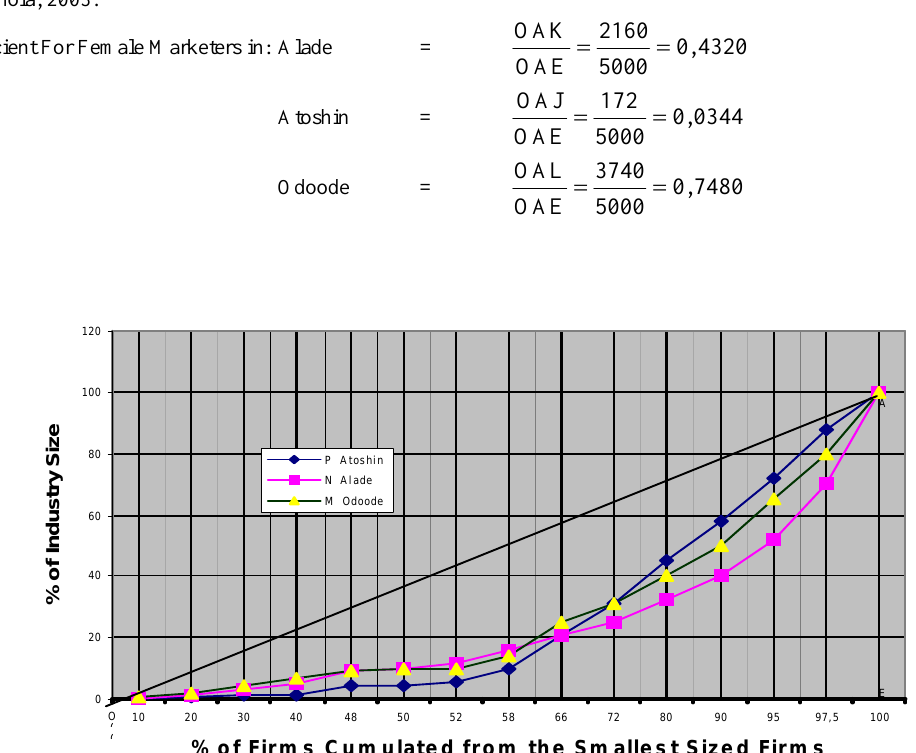
Figure 3: Lorenz curves for female marketers in cocoa industry in Alade, Atoshin, and Odoode in Idanre, Ondo State, Nigeria. 2000/2001 Season Source: Akinola, 2003.